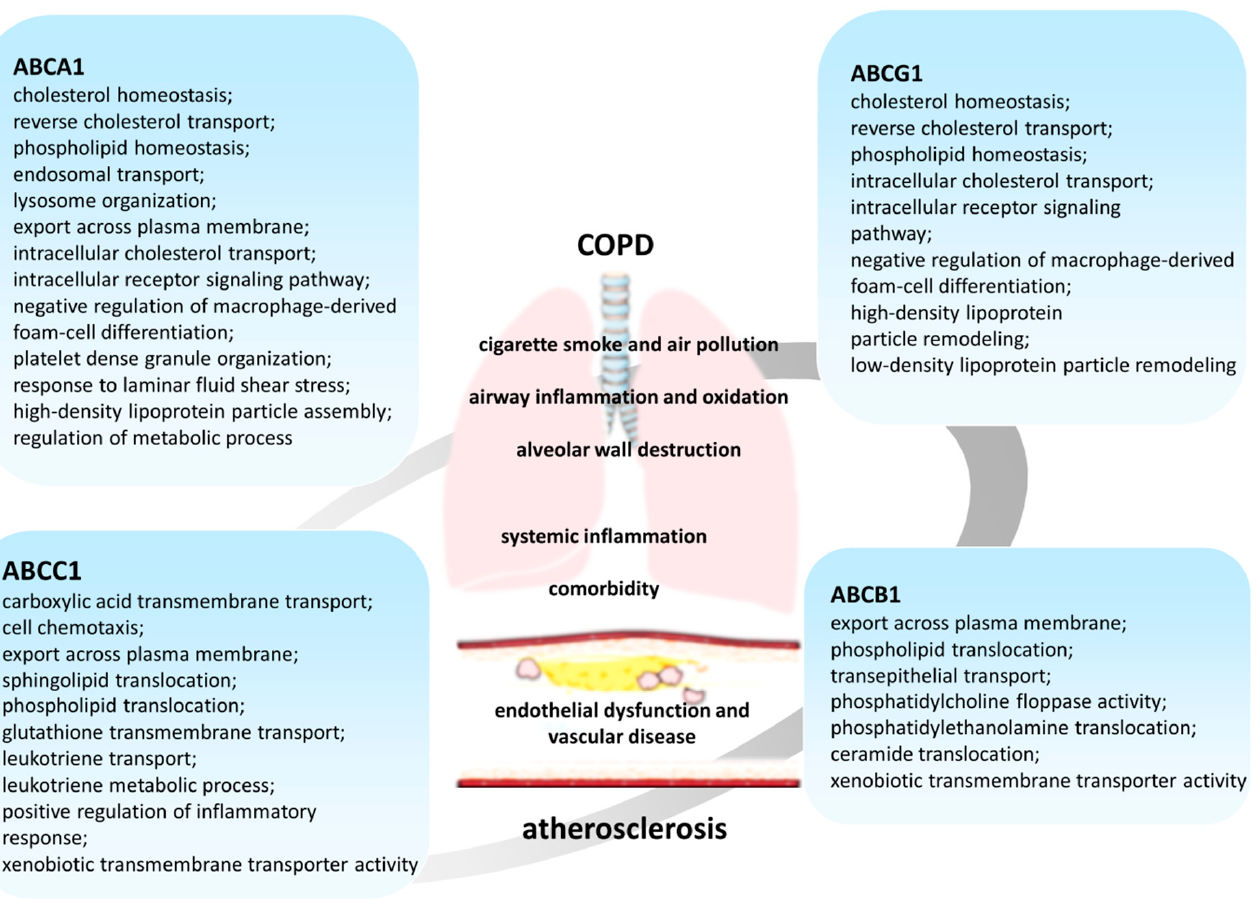
Figure 2. Biological processes and molecular functions of ABC transporters in the pathogenesis of COPD and